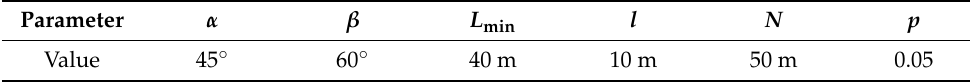
Table 6. Parameter settings during path